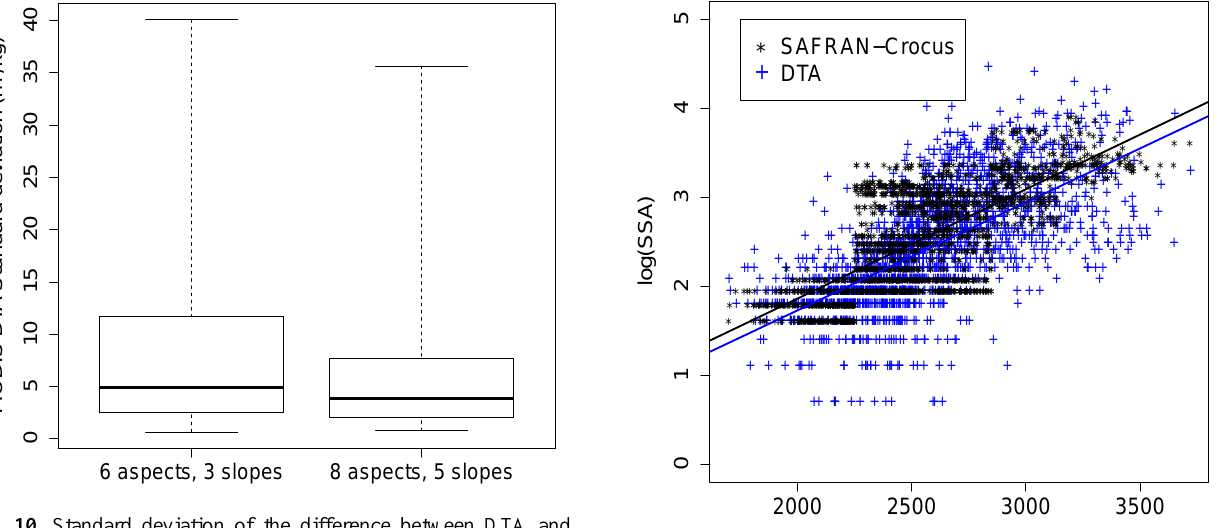
Fig. 10. Standard deviation of the difference between DTA and SAFRAN-Crocus SSA values within each topographic class of the model represented by more than 10 pixels. The values are computed including data for the six dates studied for two configurations of the model: the one presented in Section 2.5 and a reduced one using only 3 slopes (20 and 40 ◦ and flat) and 6 aspects (N, E, SE, S, SW, W). The thick black line is the median value. The box represents the first and the third quartiles. Minimum and maximum values are also indicated for each configuration.